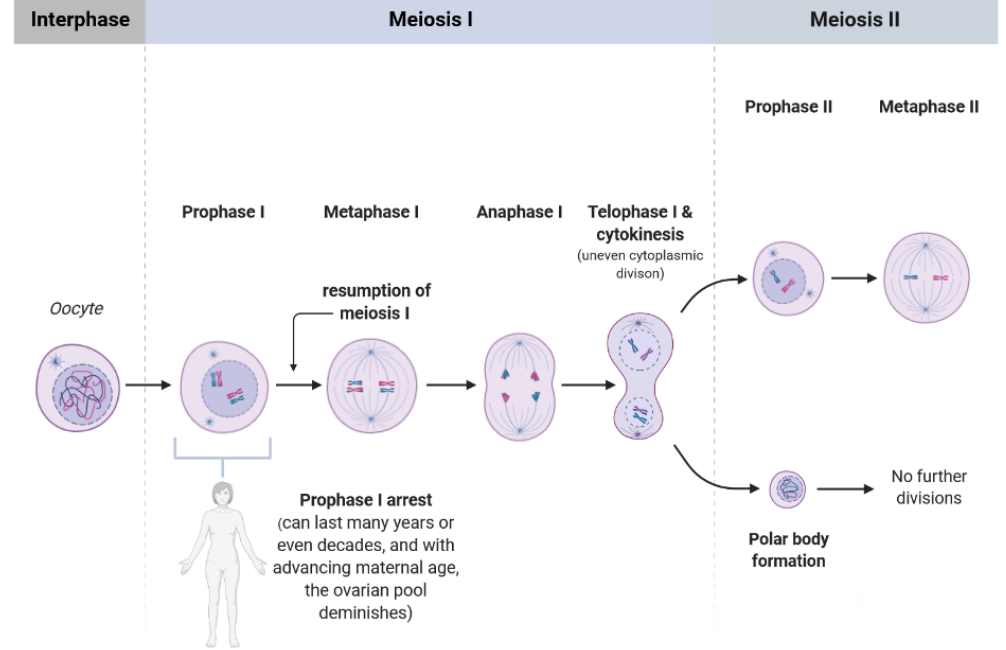
Figure 1. Scheme showing the single phases of meiosis I and II. Every girl (as most of the mammalian species) is born with a defined set of primordial follicles containing the oocytes, however, already at the onset of puberty this ovarian pool has diminished substantially. The oocytes are arrested in prophase I, and from menarche to menopause some of the oocytes are selected for further development when resumption of meiosis occurs. Thereby, the “waiting time” of an oocyte to be fertilized after reaching metaphase II could last many years, nowadays even up to 35 years or more, depending on women’s wish to become pregnant. In consequence, the chance and number of telomeric DNA damage and telomere dysfunction increase with advancing maternal age of the